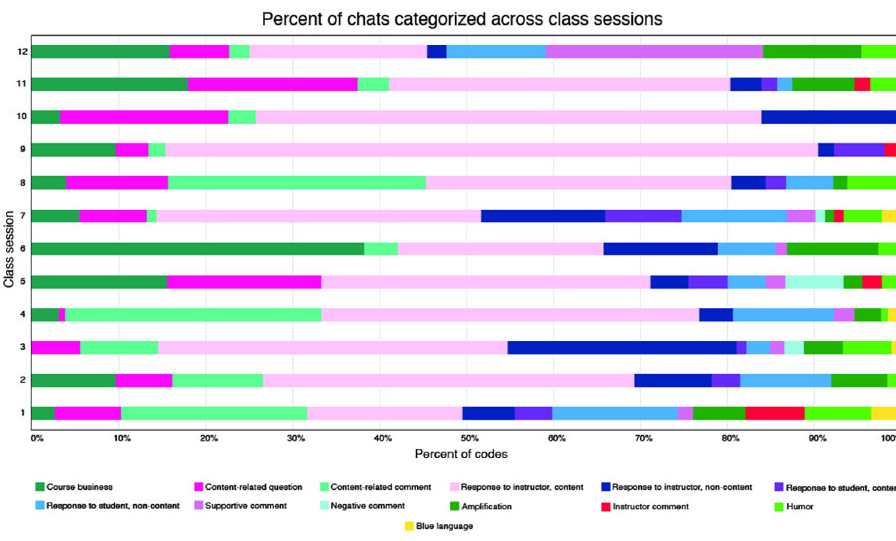
Fig 3. The results of a “dissection” of the chatting in twelve class sessions. Percentages are based on total codes, rather than total texts, thus they sum to 100% for each course. Note that many individual texts were assigned to multiple